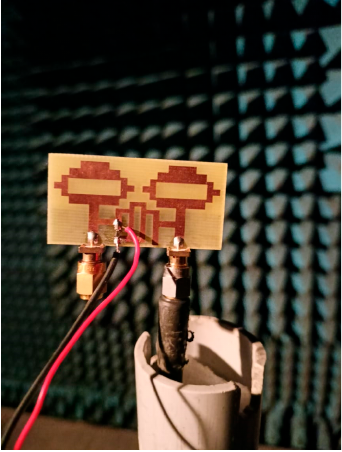
Figure 26. Anechoic chamber measurement setup for measuring the radiation pattern.